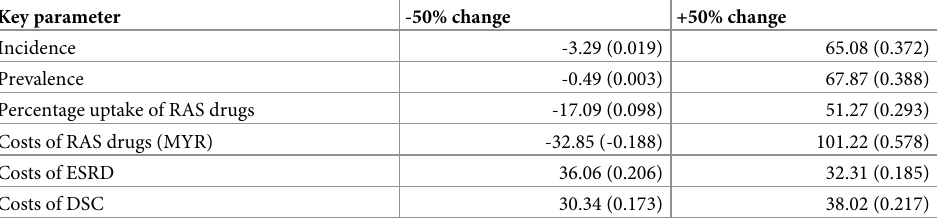
Table 4. Sensitivity analyses: Incremental total and per-member per-month (PMPM) costs (MYR) after one-year of increasing uptake of RAS drugs.